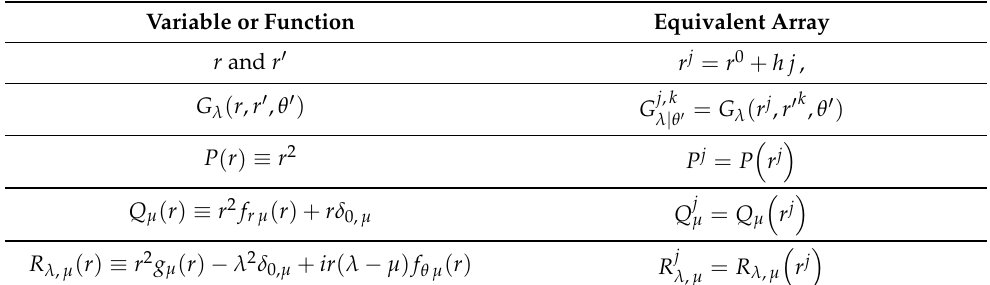
Table 1. A summary on the change of notation from continuous to discrete form. We have r 0 = R int and j ∈ { 0,1,2, . . . , N } . Variable or Function Equivalent